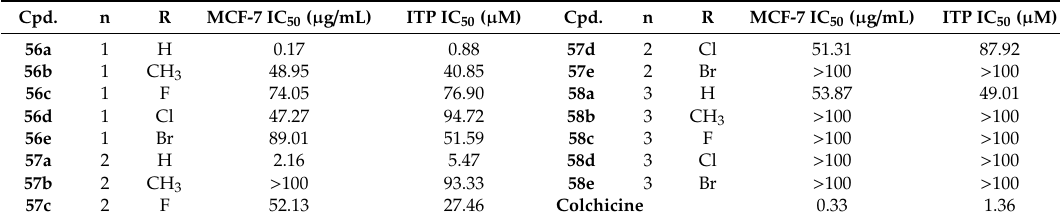
Table 7. Antiproliferative activities and anti-tubulin activities of 56a – 58e against MCF-7 cells [47]. Cpd.